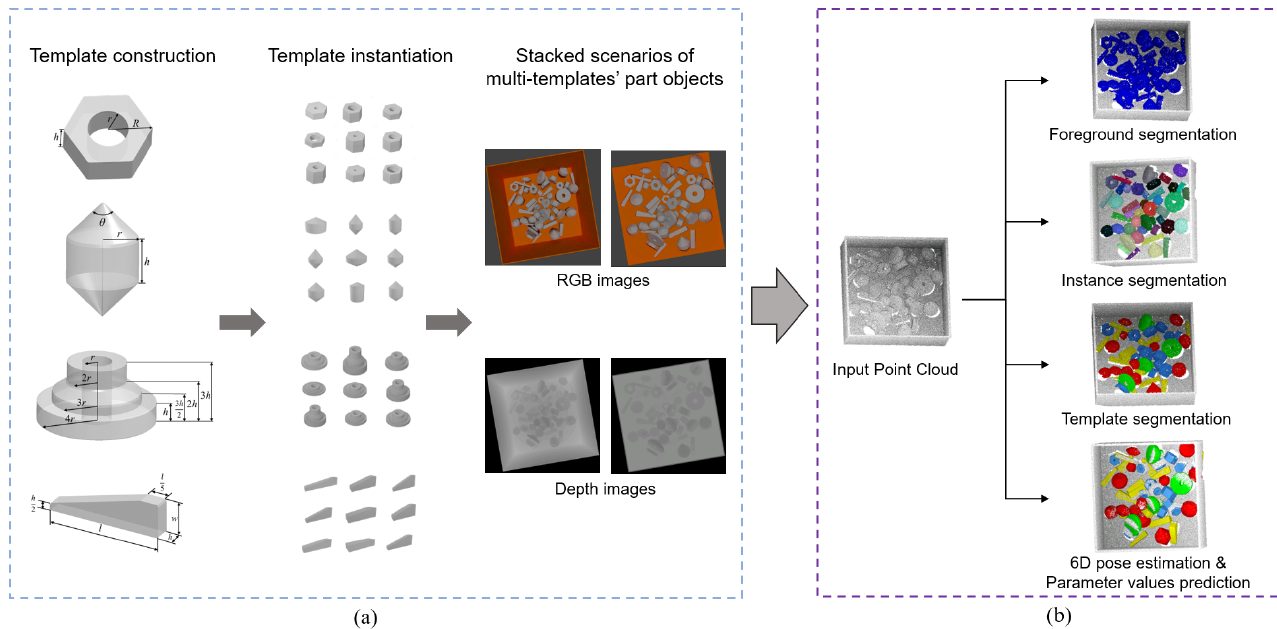
Figure 1. Pipeline of our dataset and baseline method: ( a ) Multi-Parametric Dataset, ( b ) Multi-templates Parametric Pose Network (MPP-Net). The foreground segmentation, instance segmentation and template segmentation shown in figure above are the segmentation results on the raw point cloud. To visualize 6D pose estimation and parameter values prediction, we reconstruct the part objects’ models from the template segmentation results and the parameter values prediction results, and the models are transformed in the scene by the 6D pose estimation results to overlap on the raw point